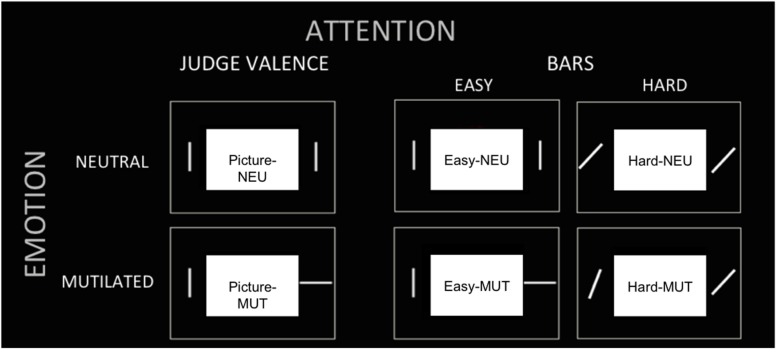
Experimental conditions. The tasks (three columns) and picture valence (two rows) are presented to illustrate the six experimental conditions: (1) “Picture NEU,” (2) “Picture MUT,” (3) “Easy NEU,” (4) “Easy MUT,” (5) “Hard NEU,” (6) “Hard MUT.”